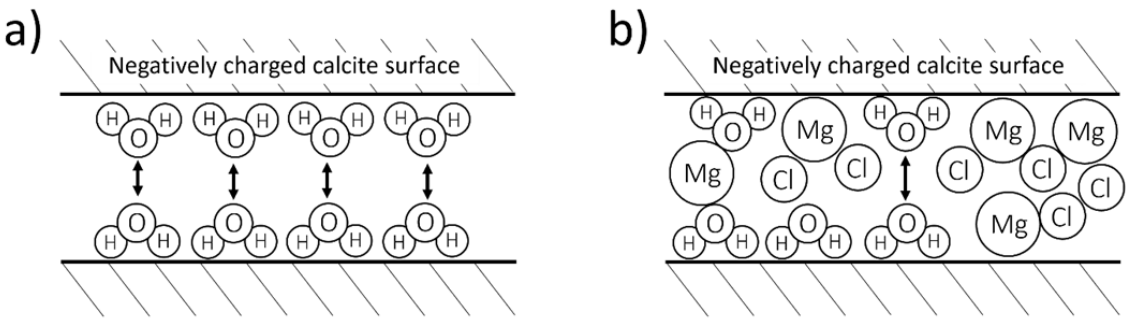
Figure 17. Schematic drawing of the repulsive effect ( a ) in a water-saturated chalk, ( b ) in a brine-saturated chalk. For the sake of simplicity, the relative size of the water molecule with respect to Mg 2+ and Cl - ions is not respected.